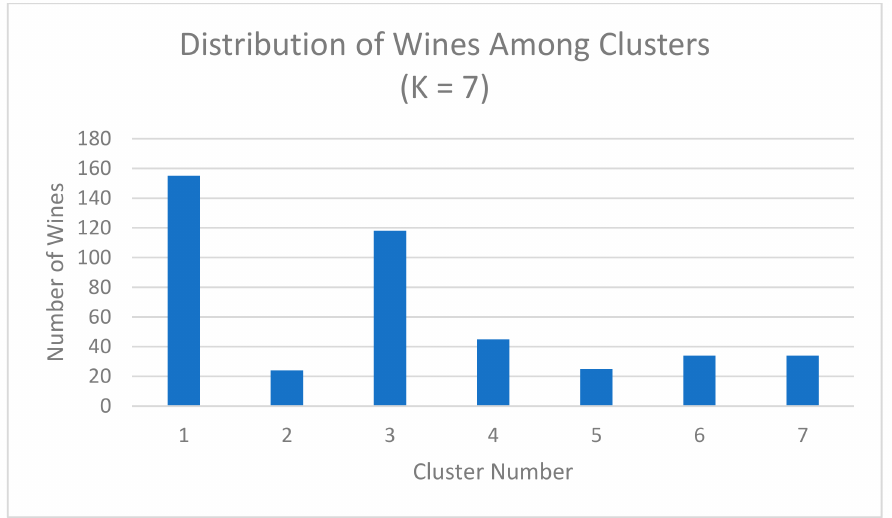
Figure 15. Number of wines per cluster with 7 clusters generated from the elite dataset. A smaller dataset and different method of feature removal accounts for the lower overall number of wines. Cluster 1 most likely represents a cluster consisting of wines that did not fit into any other